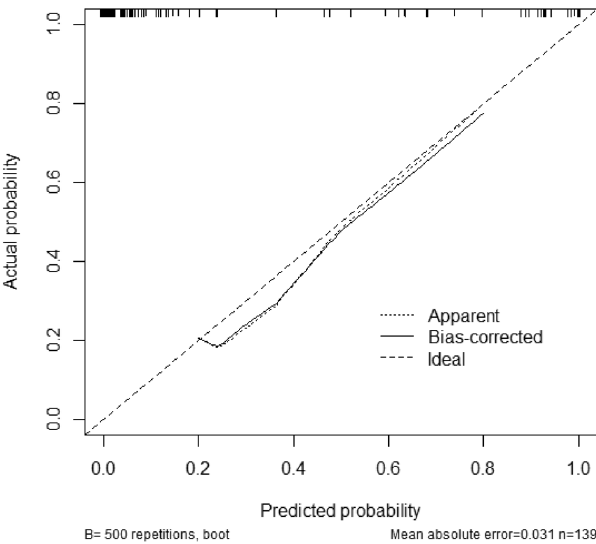
Figure 3. The calibration curve of the convention-radiomics CT nomogram.